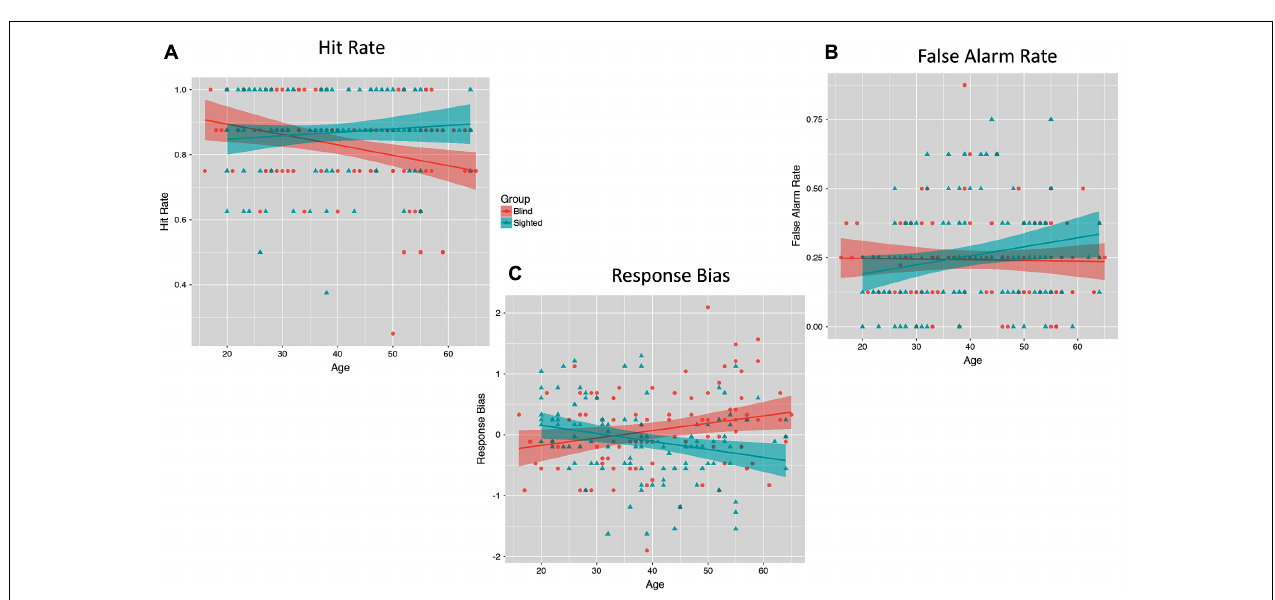
FIGURE 4 | The moderating effect of group (blind versus sighted) on the relationship between participants’ age and hit rate (A) , false alarm rate (B) , and response bias (C) .